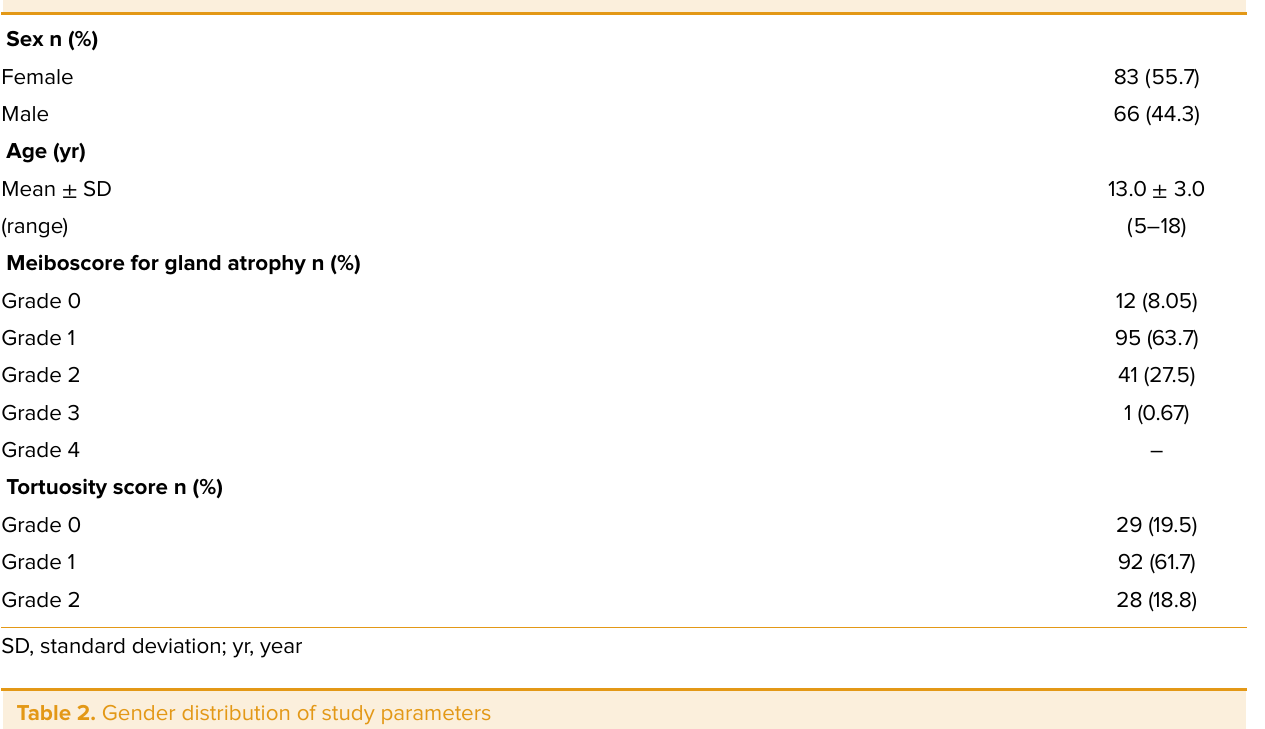
Table 2. Gender distribution of study parameters Parameter Females Males Screen time (hr) per week (Mean ± SD) Meiboscore for gland atrophy (Mean ±